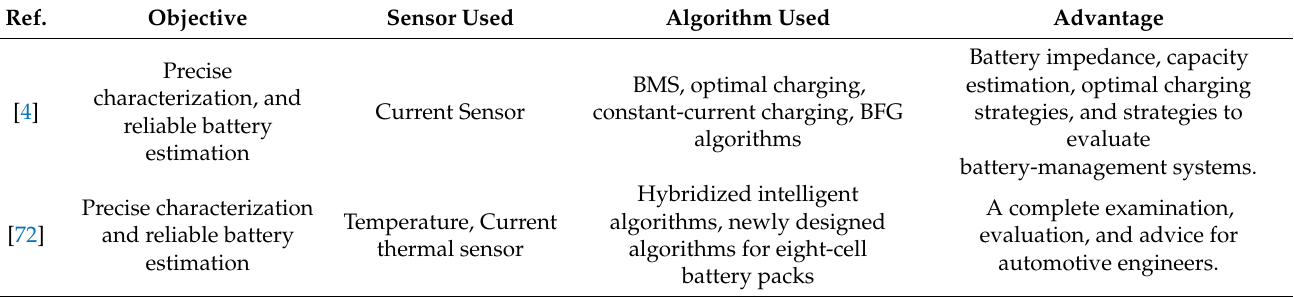
Table 7. A survey on expert systems in battery-management